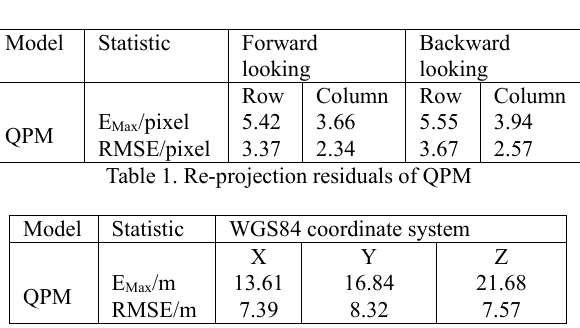
Table 1 lists maximum residuals, minimum residuals and RMSE.